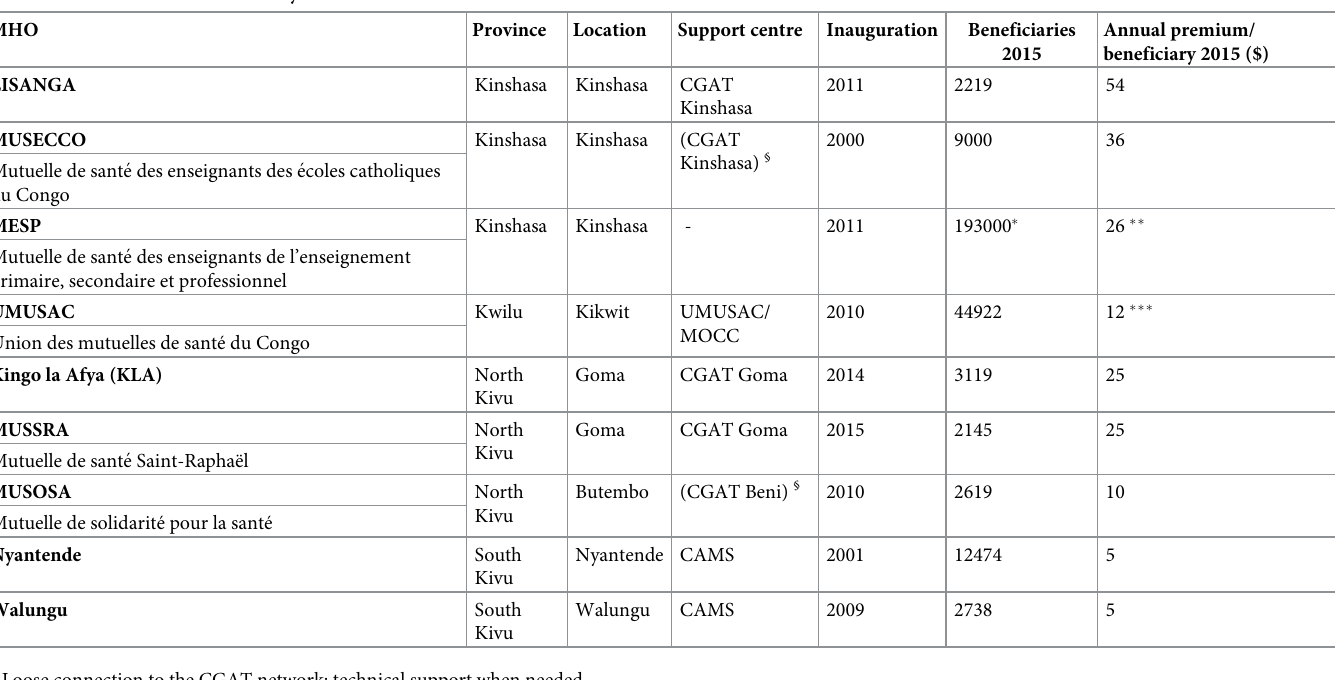
Table 3. MHOs included in the